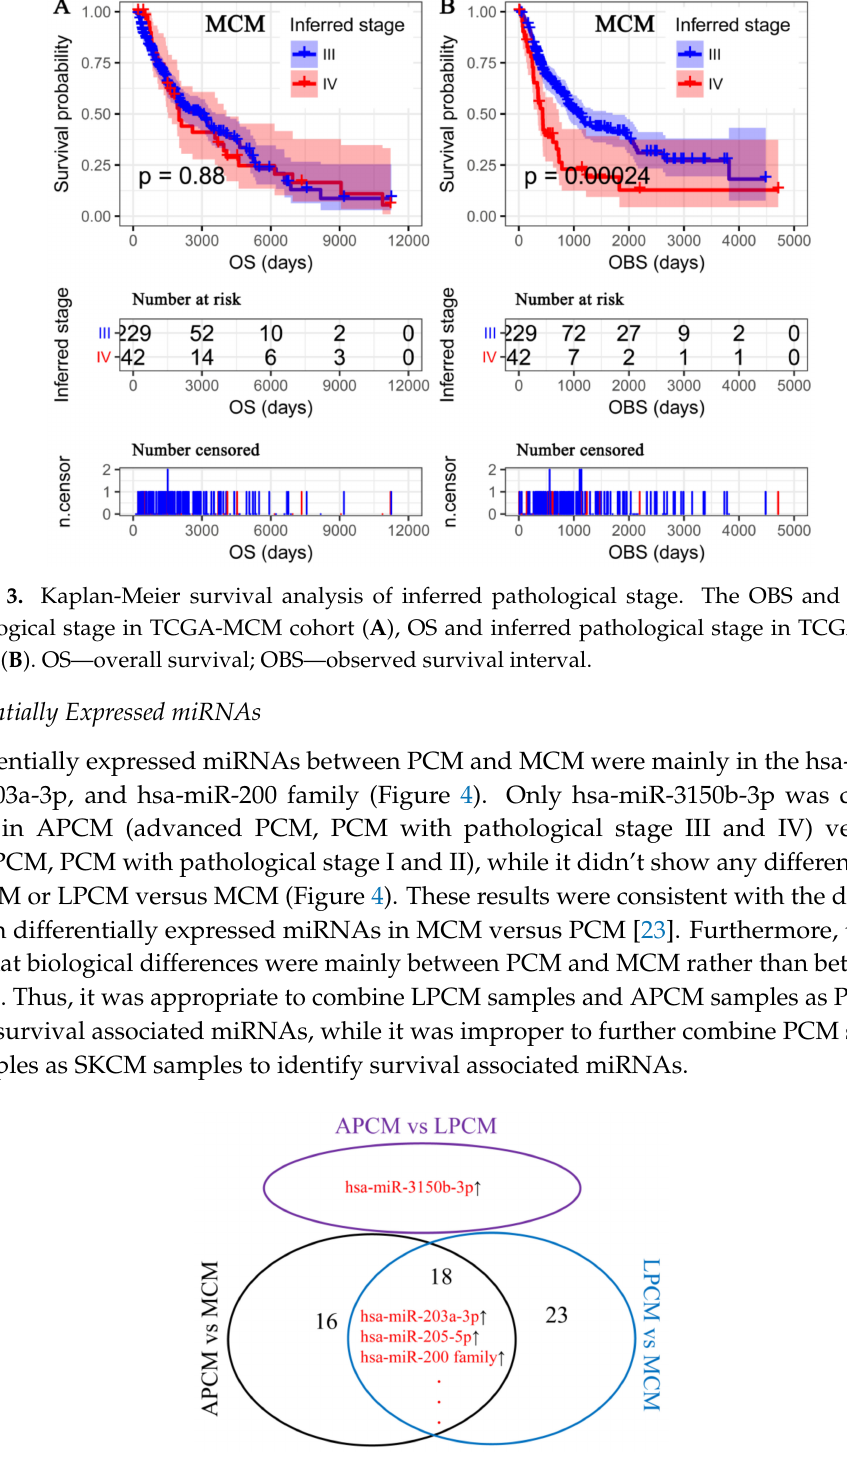
Figure 4. Venn plot of differentially expressed miRNAs of APCM versus LPCM, APCM versus MCM, and LPCM versus MCM. Arrow and number represent regulation direction and number of differentially expressed miRNAs, respectively. LPCM—localized primary SKCM; APCM—advanced primary SKCM; MCM—metastatic